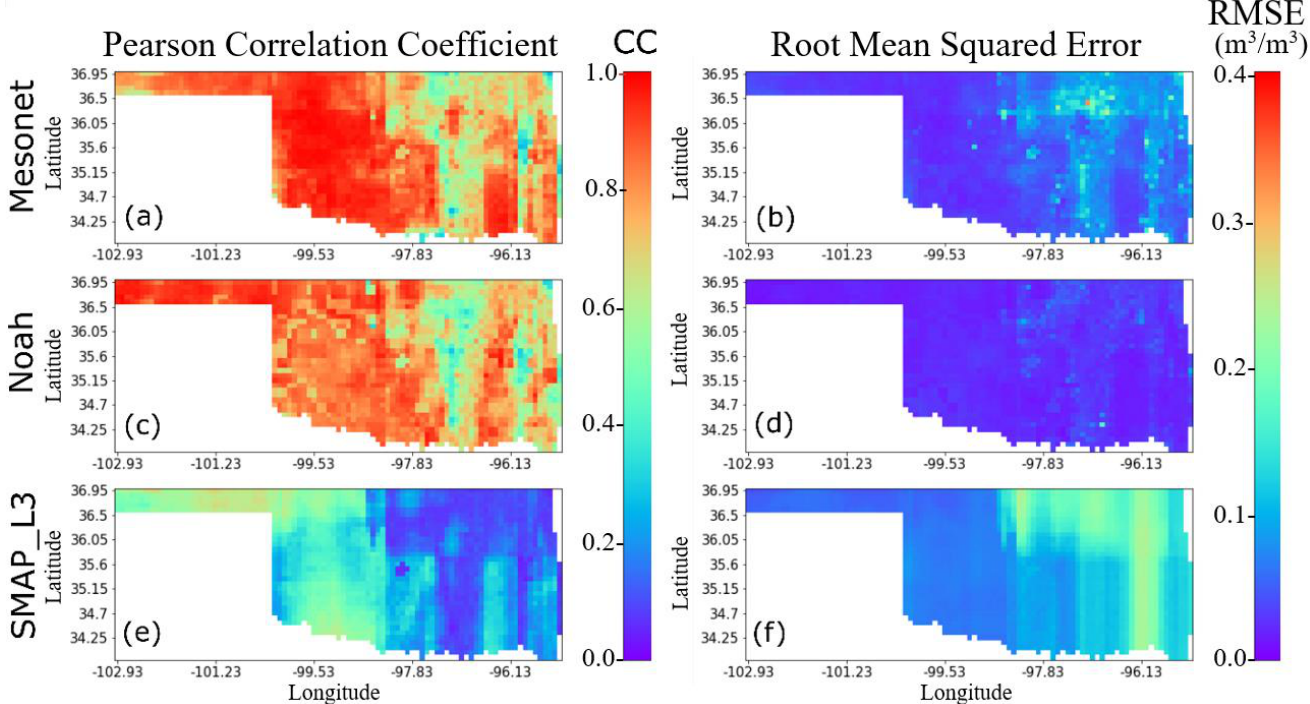
Figure 6. Product intercomparison assessment through CC (left column) and RMSE (right column) after applying the ETC method for Mesonet (first row), Noah (second row), and SMAP (third row) surface soil moisture products based on morning 6 a.m. values from April 2015 to July 2019, integrated (averaged) only during the summer season months (i.e., June, July, and August). Table 6. Climate-division averaged CC and RMSE from the TC triplets at local 6:00 a.m. from April 2015 to July 2019, for Mesonet, Noah, and SMAP during the summer season months (i.e., June, July, and August) over nine climate divisions in Oklahoma.